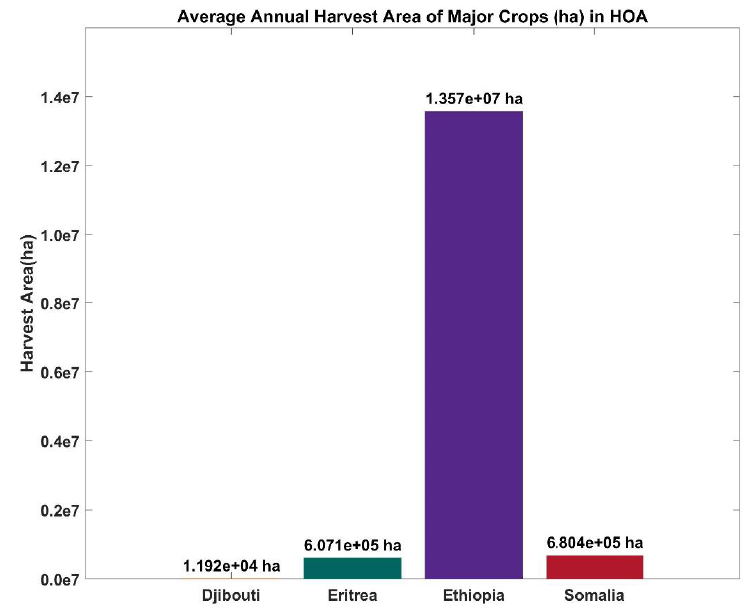
Figure 2. Average annual harvest areas of major crops in the HOA from 2001 to 2017.